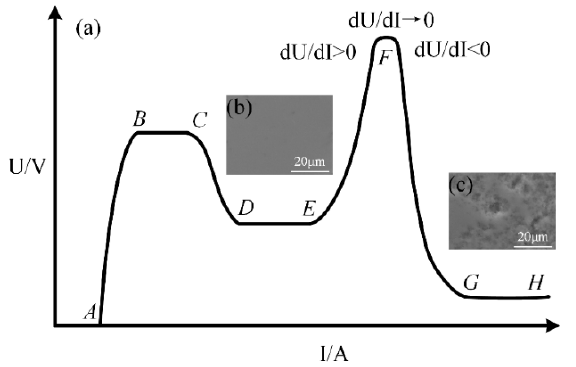
Figure 3. ( a ) I-V curve of gas discharge [29]: (AB) non-self-sustaining discharge region, (BC) Townsend discharge, (CD) subnormal glow discharge, (DE) normal glow discharge, (EF) abnormal glow discharge, (FG) transition to arc, (GH) arc discharge; ( b ) and ( c ) SEM morphologies of single-crystal 4H-SiC after removing the oxide layer formed in regions (EF) and (FG), respectively. The oxidation potential of hydroxyl radical is 2.8 eV, which means a strong oxida-